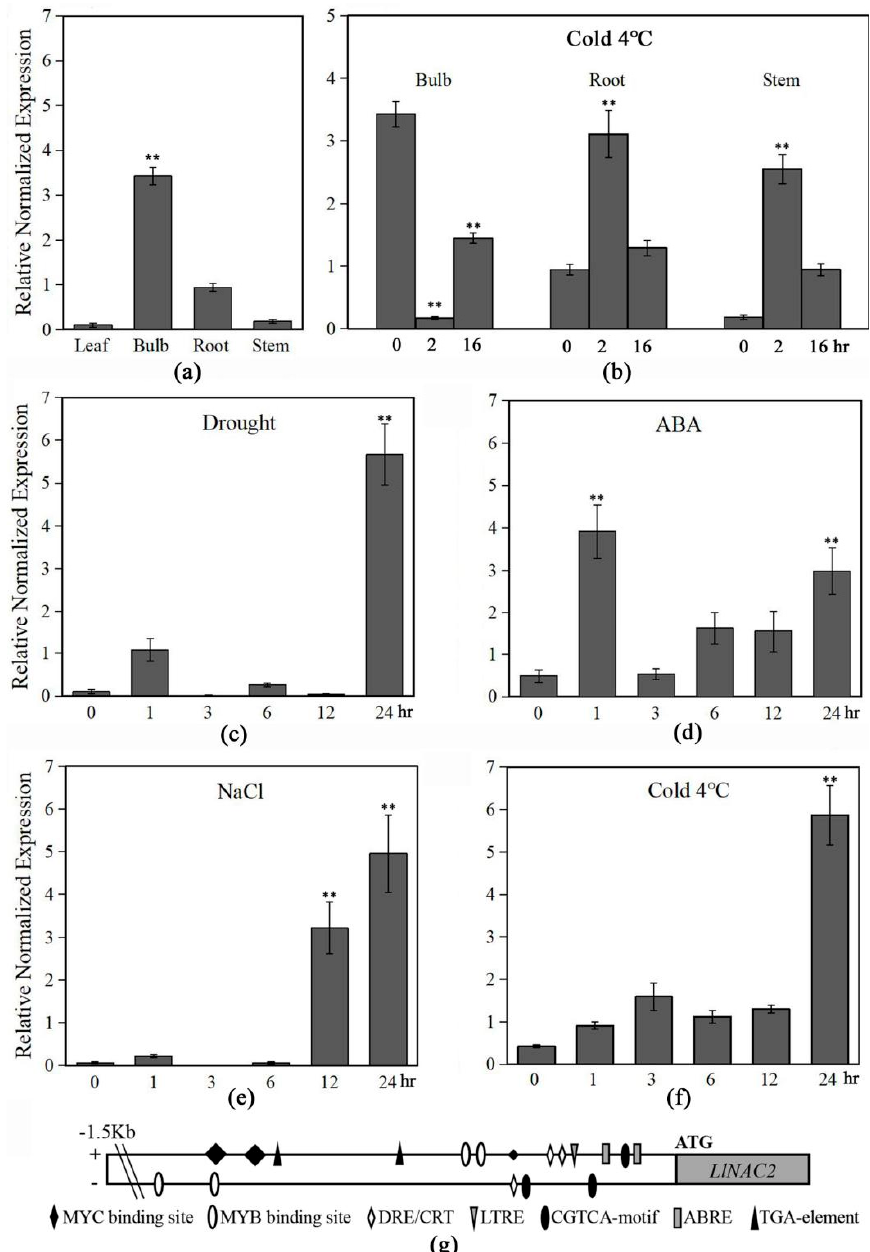
Figure 3. Expression patterns of LlNAC2 in tiger lily seedlings under different stress treatments and the distribution of stress-related cis-elements in the LlNAC2 promoter. Expression patterns of LlNAC2 in leaves, bulbs, roots, and stems ( a ), and expression patterns of LlNAC2 after cold treatments in leaves ( c ), bulbs, roots, and stems ( b ), and after ABA ( d ), NaCl ( e ), drought ( f ) treatments by qRT-PCR analysis. Transcript levels were normalized to LlTIP1 . Three biological replications were performed. The bars show the SD. Asterisks indicate a significant difference ** p < 0.01 compared with the corresponding controls. ( g ) Distribution of major stress-related cis-elements in the promoter region of LlNAC2 gene.